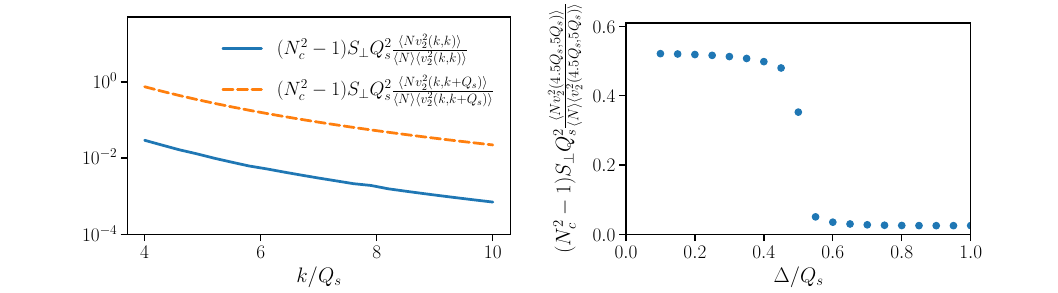
N (cid:5) as a function of the bin width 2